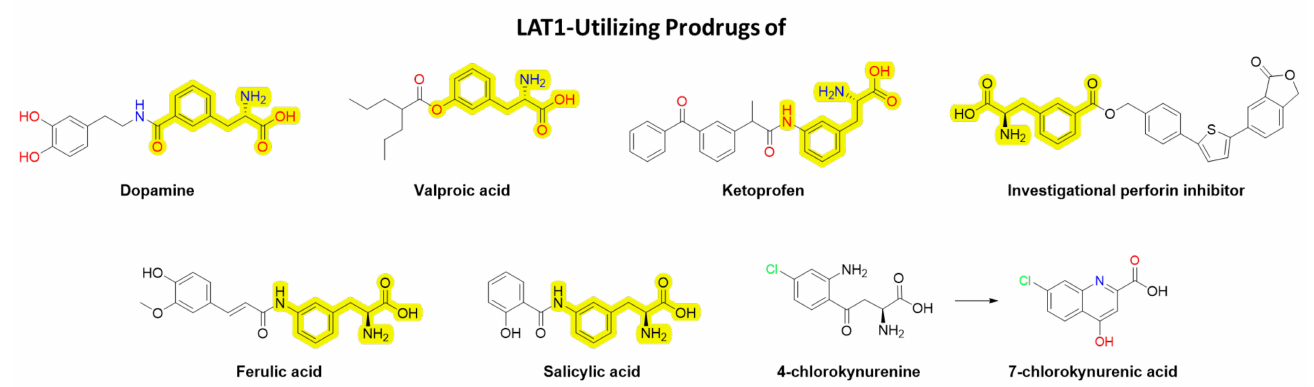
Figure 7. Molecular structures of prodrugs that can utilize LAT1 with promoieites highlighted with yellow color, excluding 4-chlorokynurenine, which undergoes internal cyclization to produce 7-chlorokynurenic